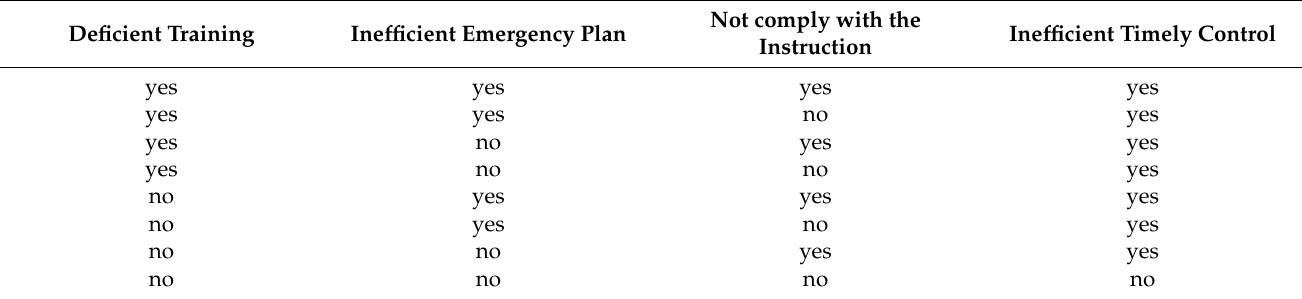
Table A2. CPT for the BN node ‘inefficient timely